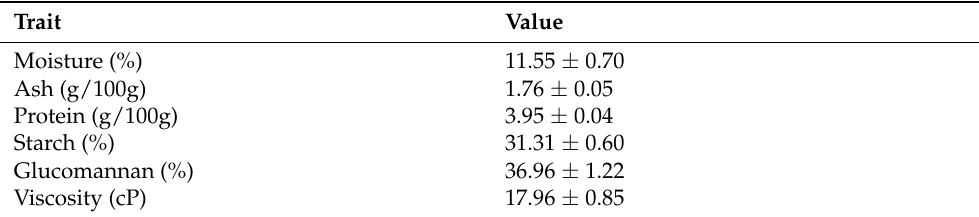
Table 5. Biochemical properties of Salep powder obtained from endangered terrestrial orchid species H. affine (Boiss.)